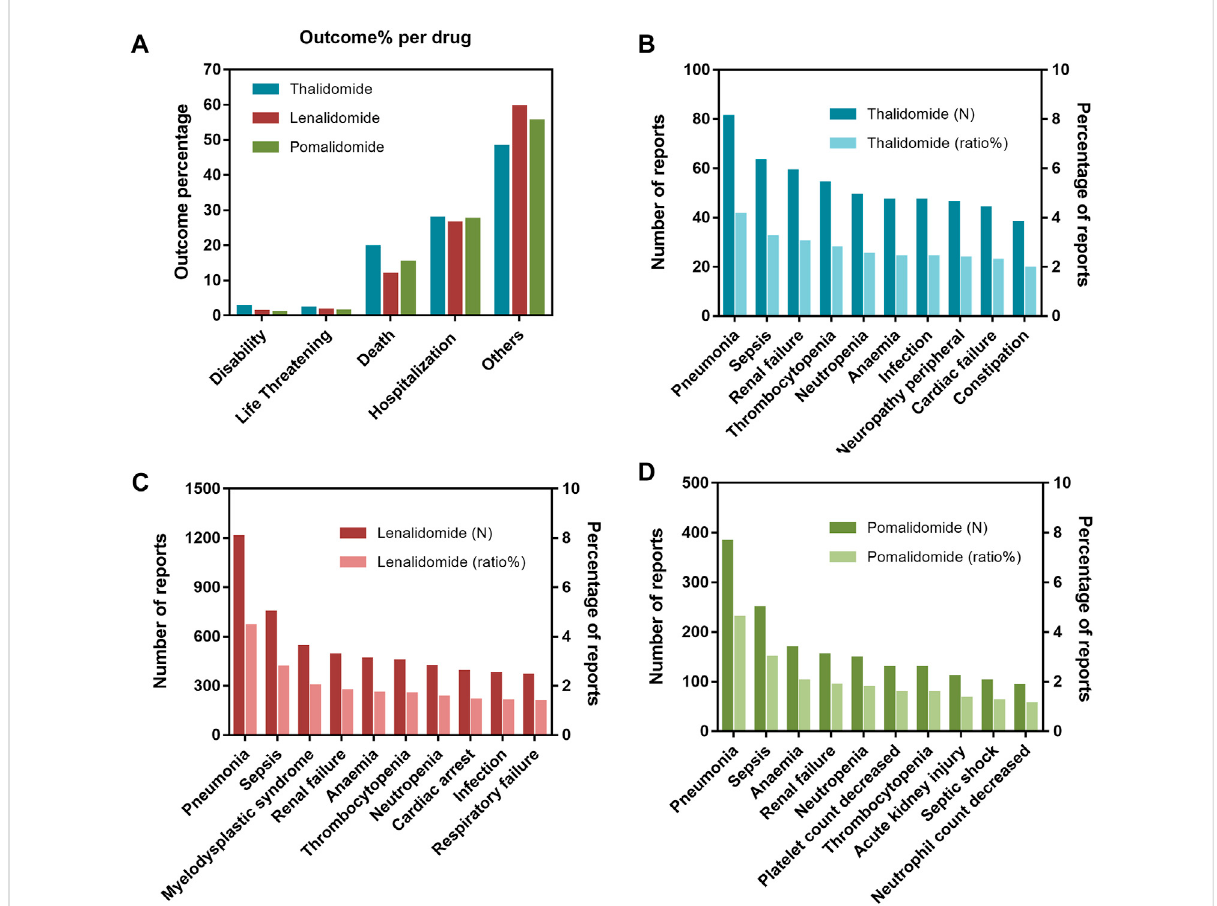
FIGURE 1 (A) Outcomes for adverse events (AEs) associated with immunomodulatory drugs (IMiDs). (B) The top 10 AEs leading to death for thalidomide. (C) The top 10 AEs leading to death for lenalidomide. (D) The top 10 AEs leading to death for pomalidomide.